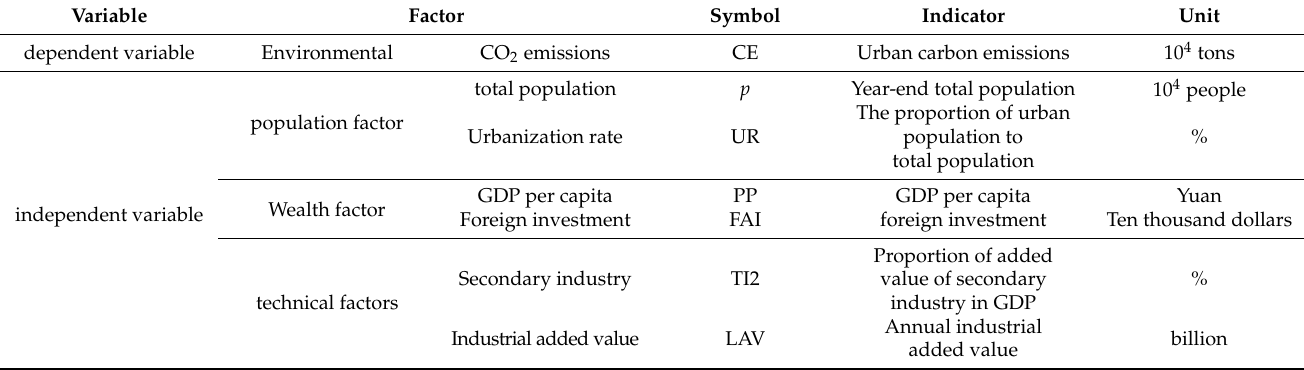
Table 3. STIRPAT model variable